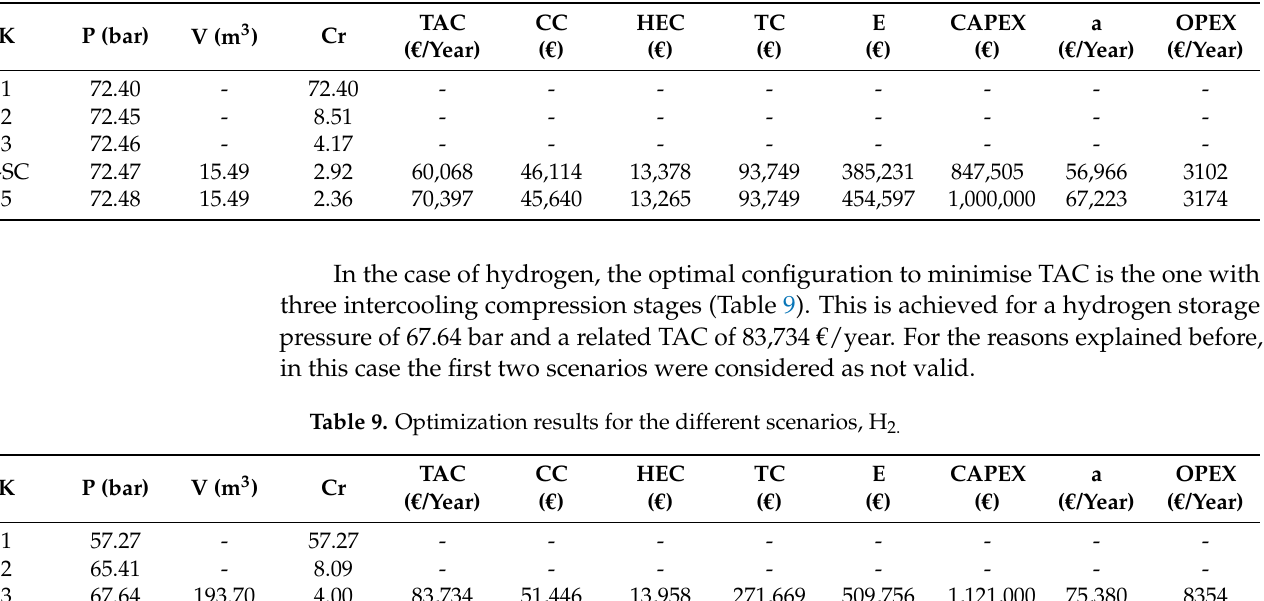
Table 8. Optimization results for the different scenarios, CO 2 .